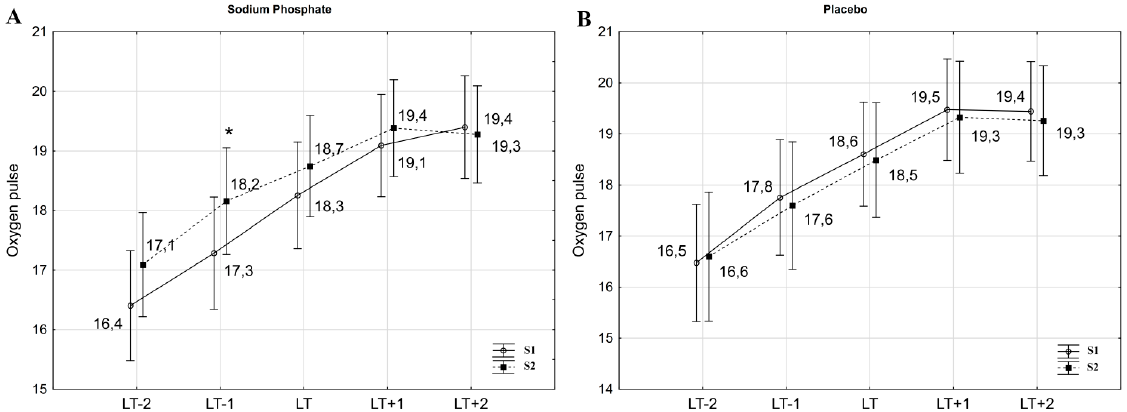
Figure 2. Heart rate (HR) during exercise in hypoxia before (S1) and after (S2) sodium phosphate ( A ) and placebo ( B ) ingestion. ** p < 0.01 S1 vs. S2. LT − 2, LT − 1, LT, LT+1, LT+2—absolute workload corresponding to workload at lactate threshold (LT) as well as one and two workloads below and above LT which were determined during the initial exercise test (S1).